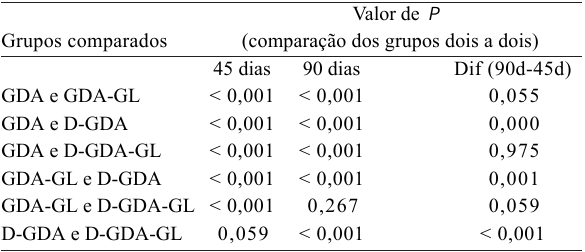
Tabela 3. Comparação entre grupos no mesmo tempo de explante e as diferenças entre os tempos de explante.